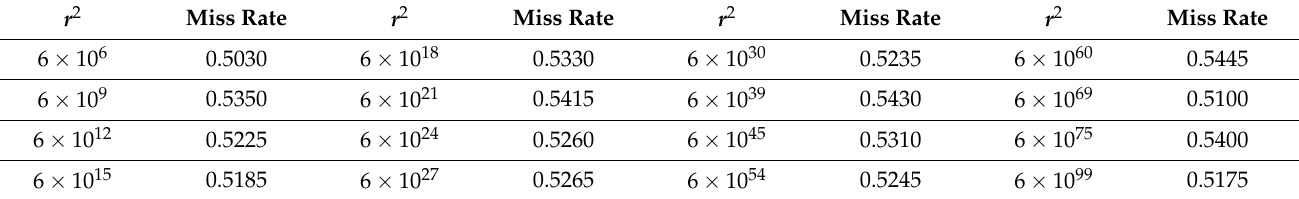
Table 6. RR miss rate as r 2 increases with ρ fixed at 5% and ω fixed at